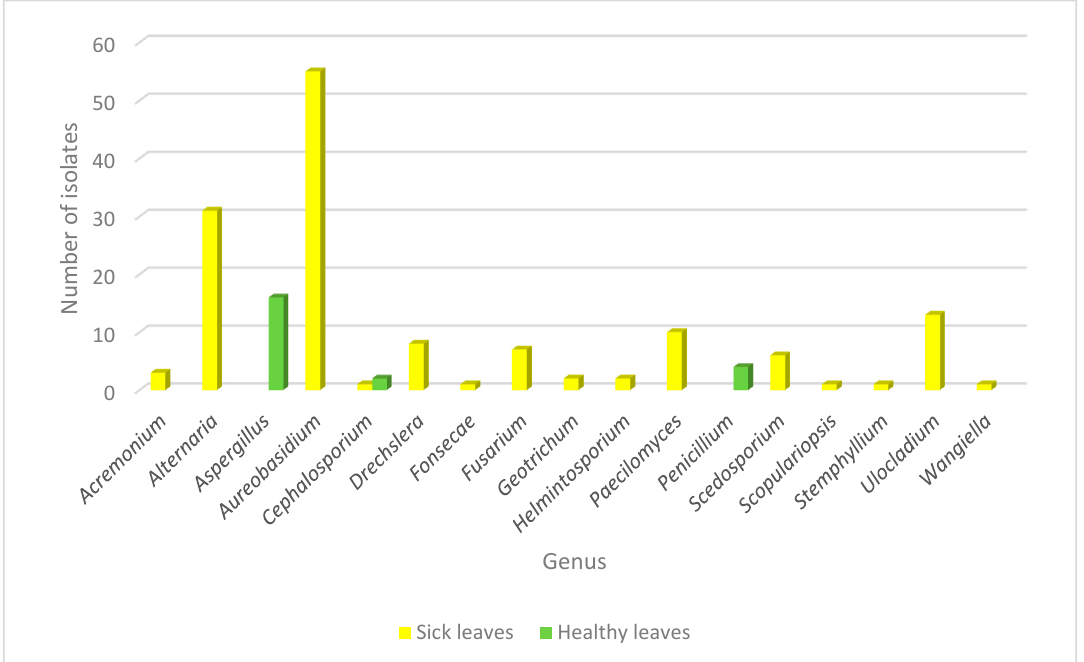
Figure 3. Abundance of fungal genera isolated from diseased and healthy leaves in Crataegus . Fungal distribution identified in the endophytic and epiphytic population in healthy (green) and sick (yellow) leaves is shown.